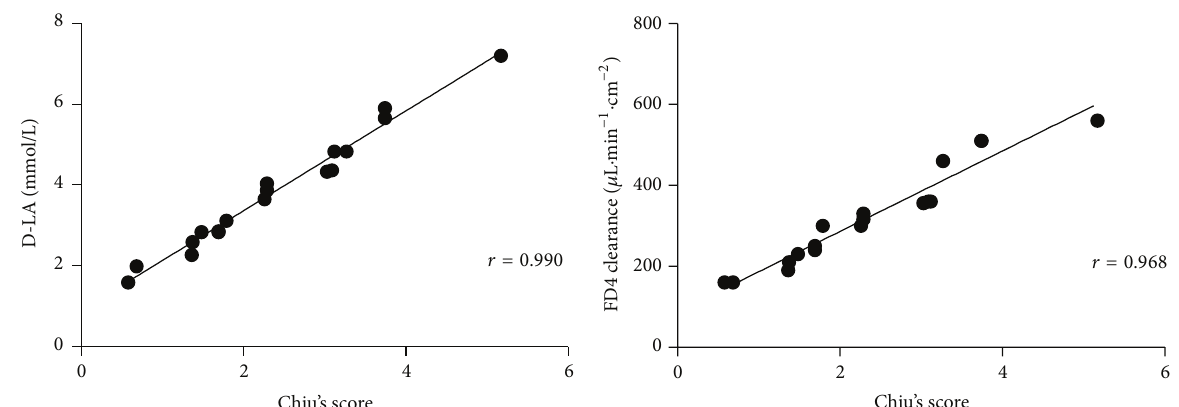
Figure 5: The analysis of correlation between D-lactate levels and Chiu’s scores, and the correlation between the values of intestinal clearance of FD4 and Chiu’s scores, respectively (𝑃 = 0.000)